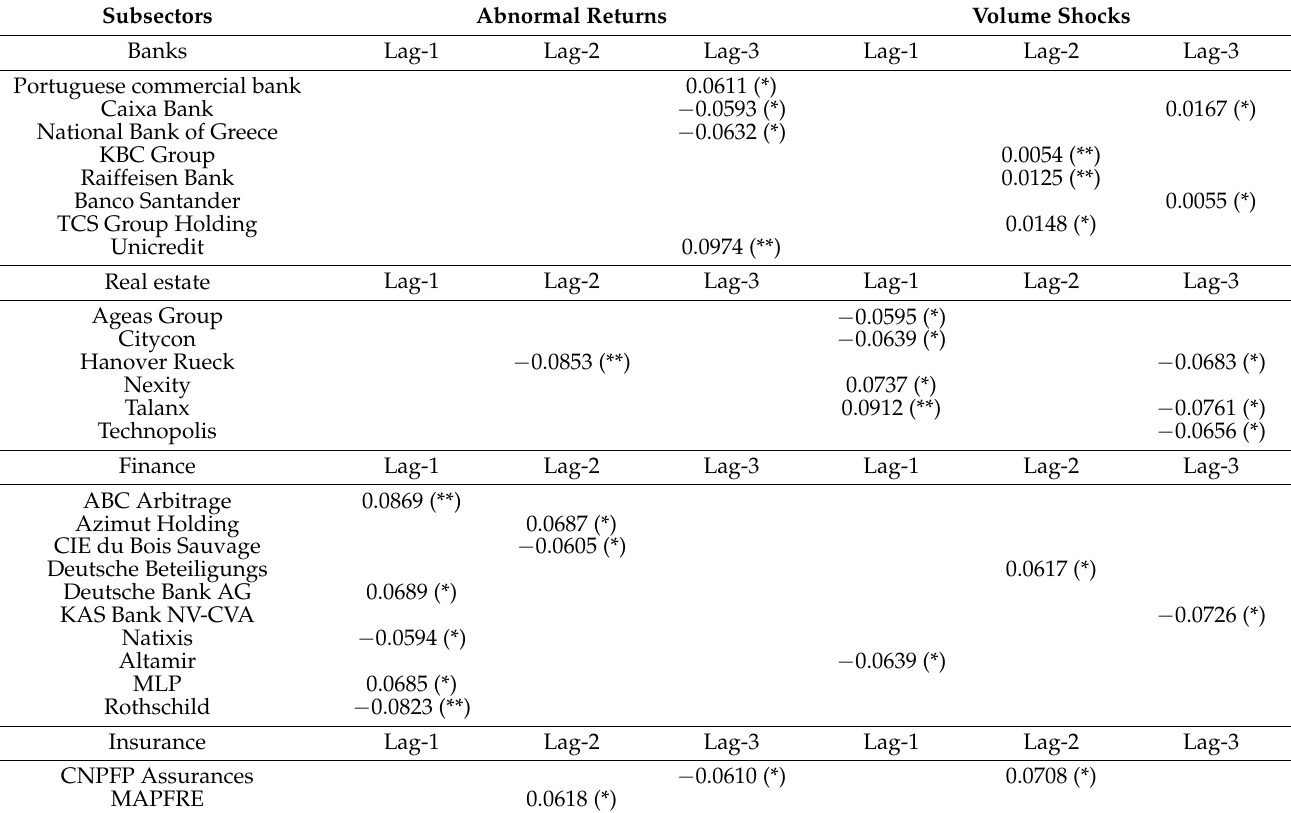
Table 6. Individual estimate of the influence of the investor sentiment